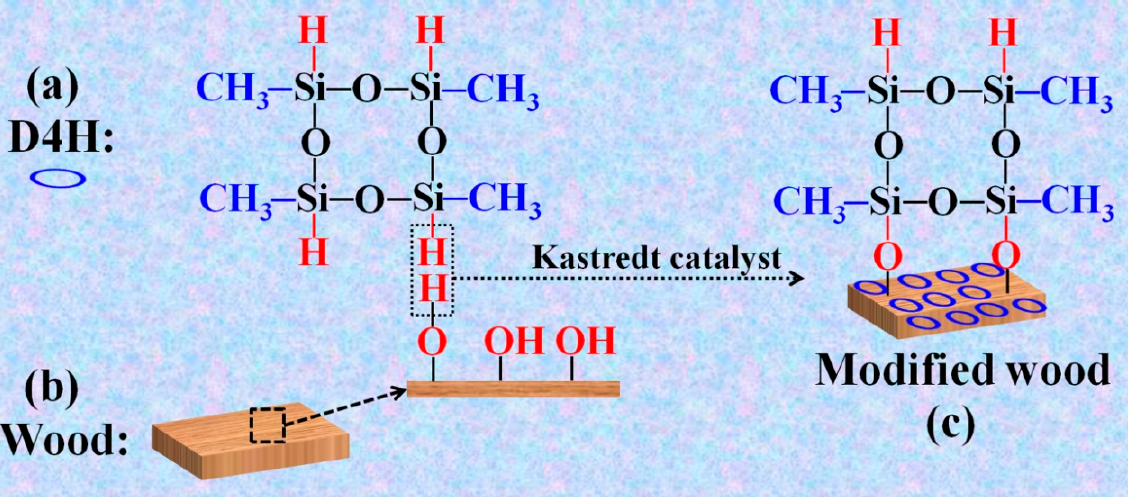
Figure 1. Schematic representation of the process for obtaining the D4H modified wood: ( a ) D4H structure; ( b ) Wood; ( c ) Modified wood.